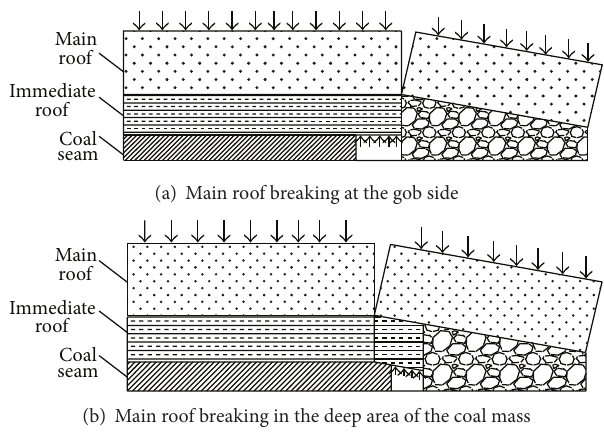
Figure 10: Schematic diagram of the breakage position of the main roof.